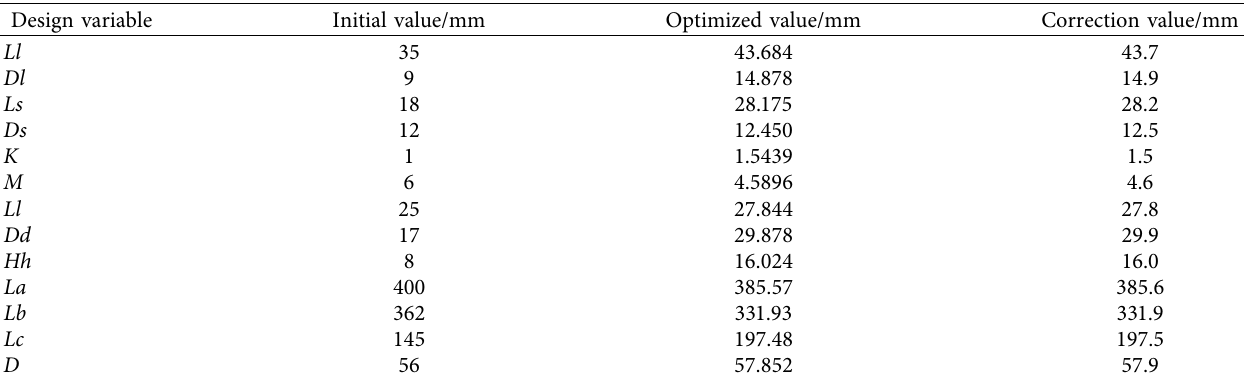
Table 5: Tenon structure size parameters.